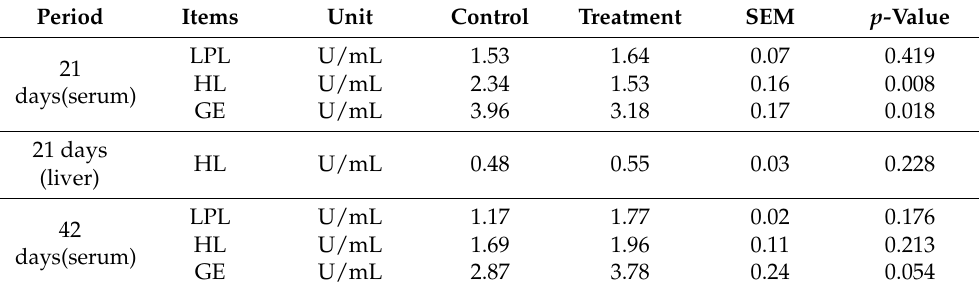
Table 6. Effects of lecithin on the enzyme activity in serum and liver of broilers at 21 and 42 days 1 . Period Items Unit Control Treatment SEM p- Value 21